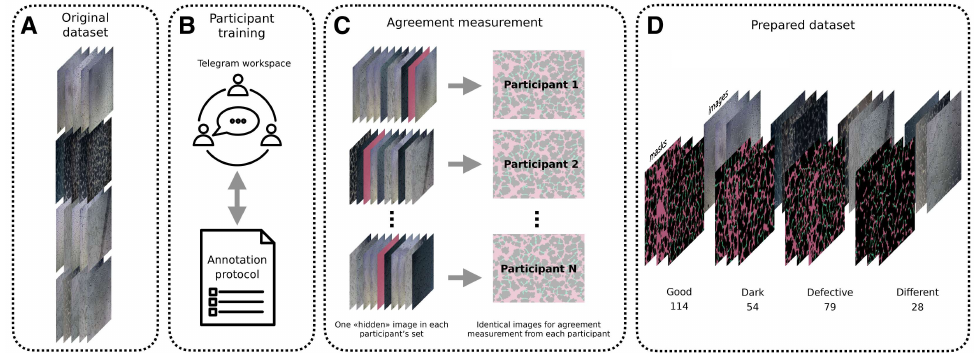
Figure 7. Illustration of workflow. ( A ) The original dataset. ( B ) Labelling was conducted using the online service CVAT with communication through Telegram. During the discussion, the annotation protocol—a set of rules describing the definitions of tubes and nodes for marking—was formed. ( C ) During the data-labelling process, the agreement coefficient was measured periodically to verify that the obtained data were correct. Each member of the labelling group had one identical “hidden” image periodically added to the set of 10 images, and then the labelling of that image from all participants was compared. ( D ) The result was a dataset with a total of 275